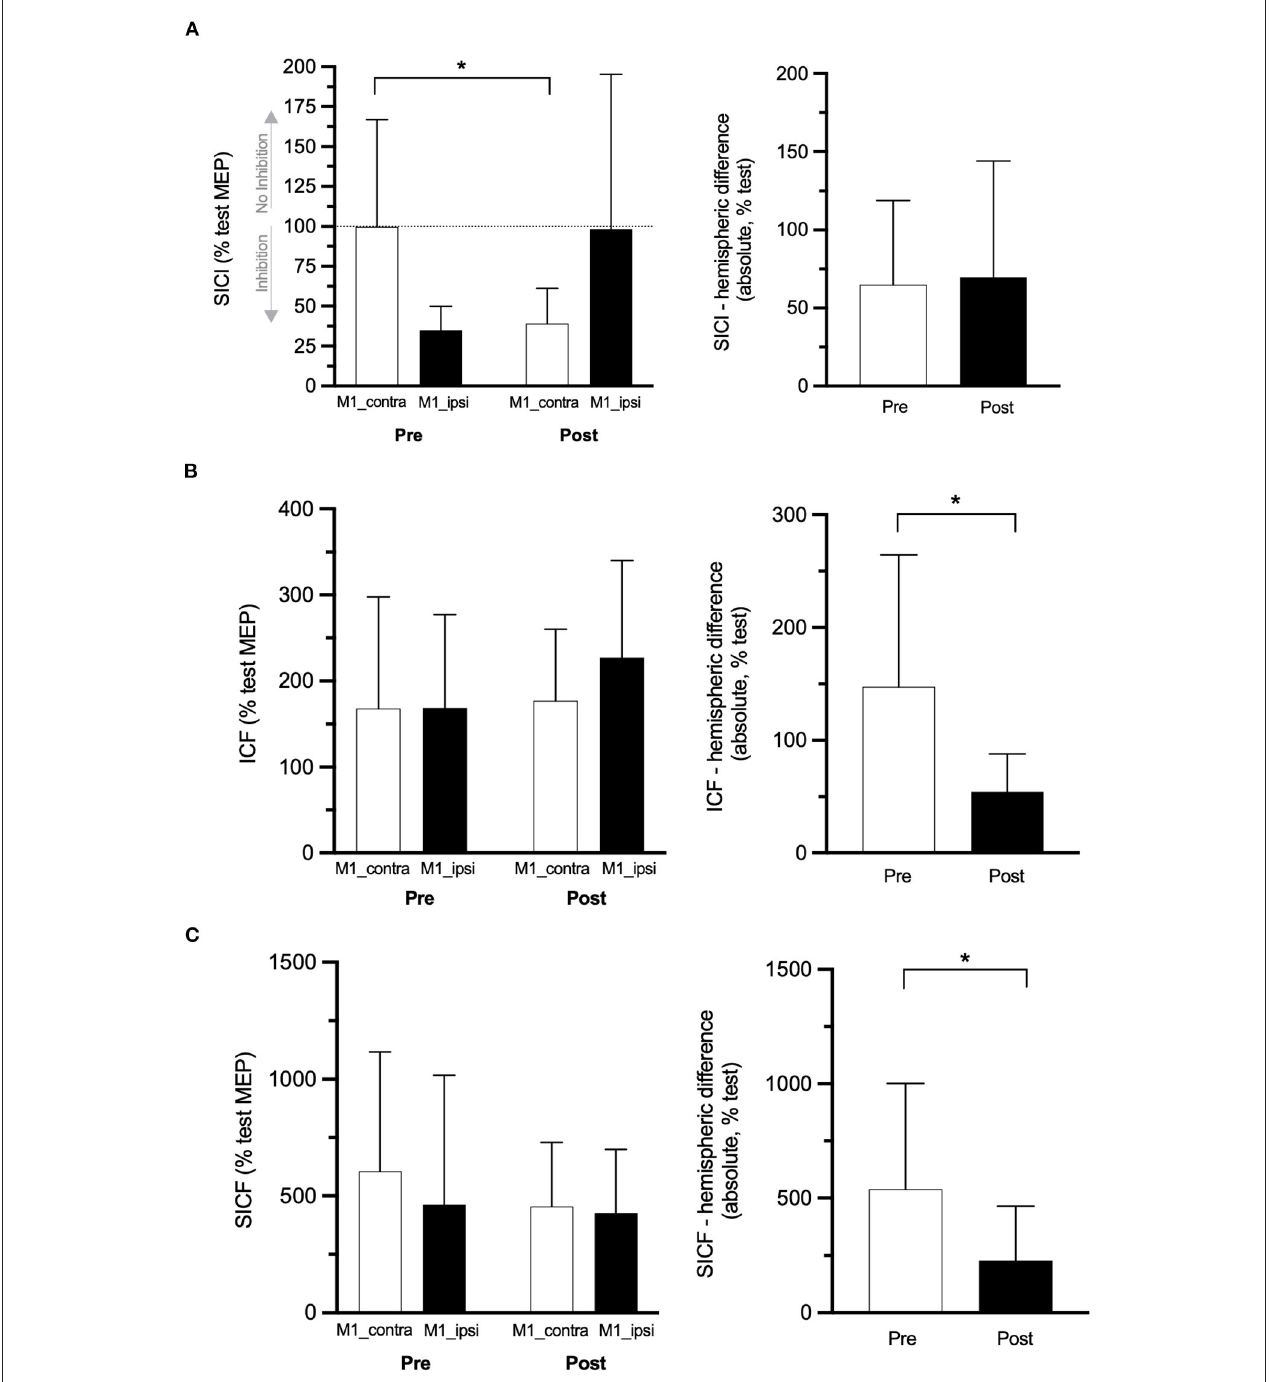
FIGURE 3 | Paired-pulse TMS outcomes. SICI (A) , ICF (B) , and SICF (C) data at pre- and post-rPMS in M1 contralateral to the CRPS side (M1_contra: white histograms) and M1 ipsilateral (M1_ipsi: black histograms) on the left panel and, on the right panel, their absolute between-M1 difference at pre- and post-rPMS (white and black histograms, respectively). SICI, ICF, SICF: conditioned MEP of short-interval intracortical inhibition, intracortical facilitation, and short-interval intracortical facilitation. * p < 0.05 between pre- and post-rPMS (for M1_contra only in A ). rPMS (228.5 ± 237.5%) was decreased as compared to difference after rPMS (54.4 ± 32.5%) was decreased as compared pre-rPMS (538.9% ± 90.11%, t 6 = 3.28, p = 0.017; Figure 3C , to pre-rPMS (147.3 ± 111.5%, t 6 = 2.42, p = 0.052; Figure 3B , right right panel). The absolute SICF hemispheric difference after